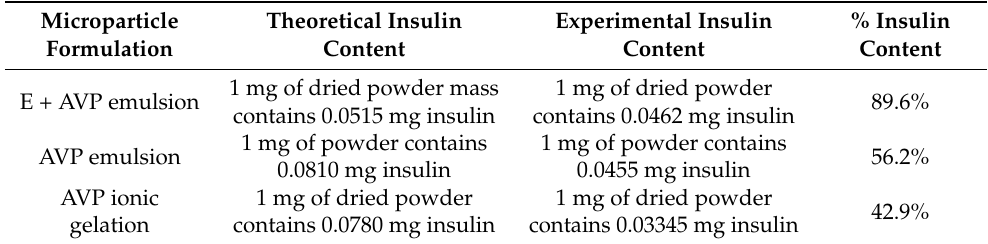
Table 1. Percentage insulin content of the microparticle